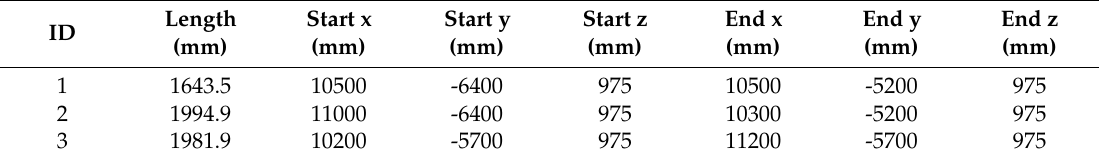
Figure 16. An instance of dynamic path planning simulation: ( a ) Lateral view; ( b ) Front view. The obstacle (red block) moves inwards towards the robot (path shown as a series of green crosses) as it begins executing an initially planned path (blue line). As the obstacle obstructs this plan, the planner continues to find a new feasible path, which results in the final executed trajectory shown as red circles (indicating the time evolution of the trajectory). Table 2. Three planning problems used to assess the computational efficiency of the planner.